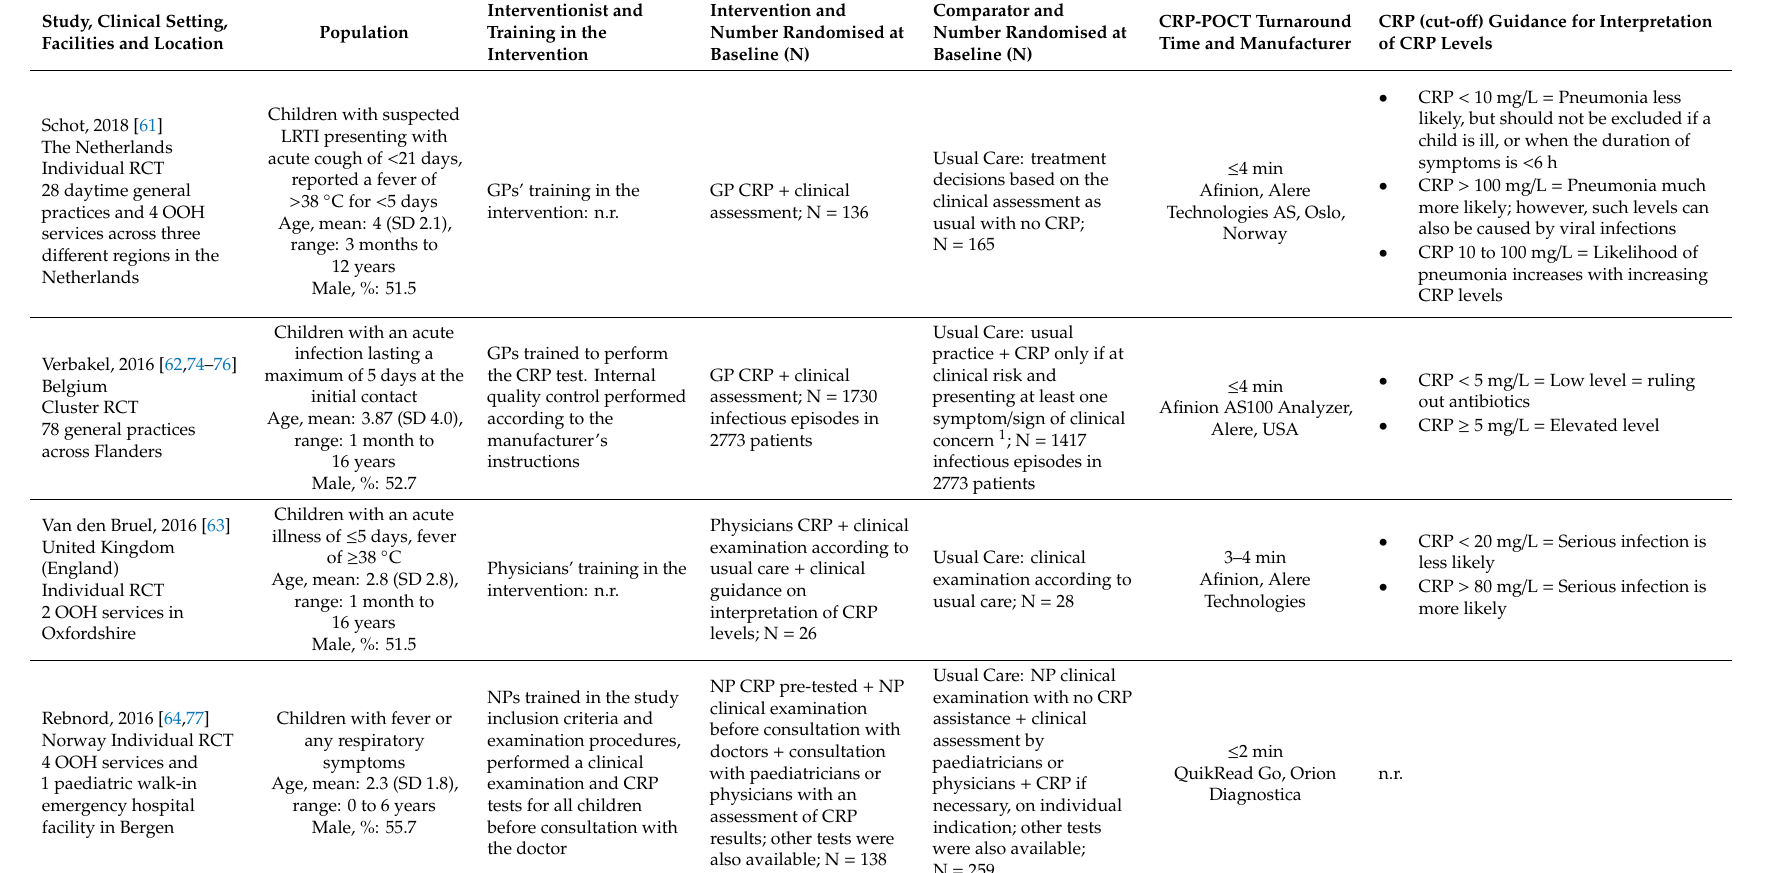
Table 1. Characteristics of studies included in the